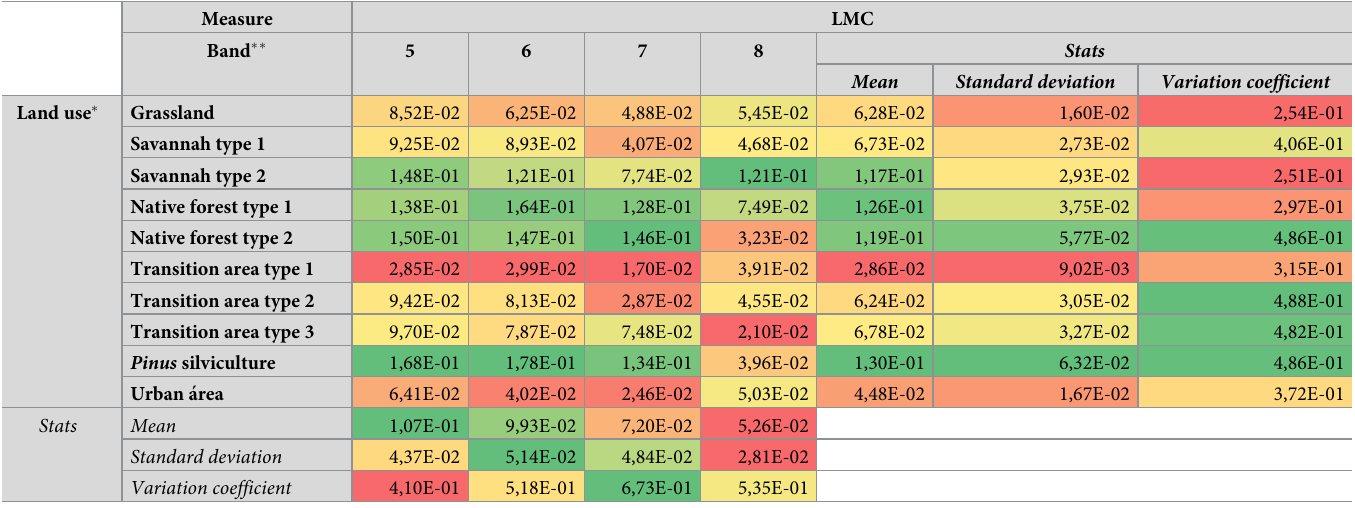
Standard deviation Variation coefficient